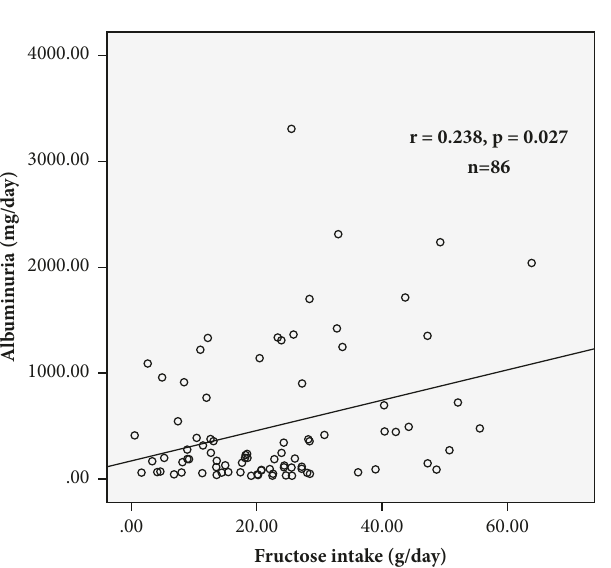
Figure 3: Association between fructose intake (g/day) and albu- minuria (mg/day) in subjects with albuminuria between 30 to 3500 g/day, obtained by Spearman correlation test (n=86).